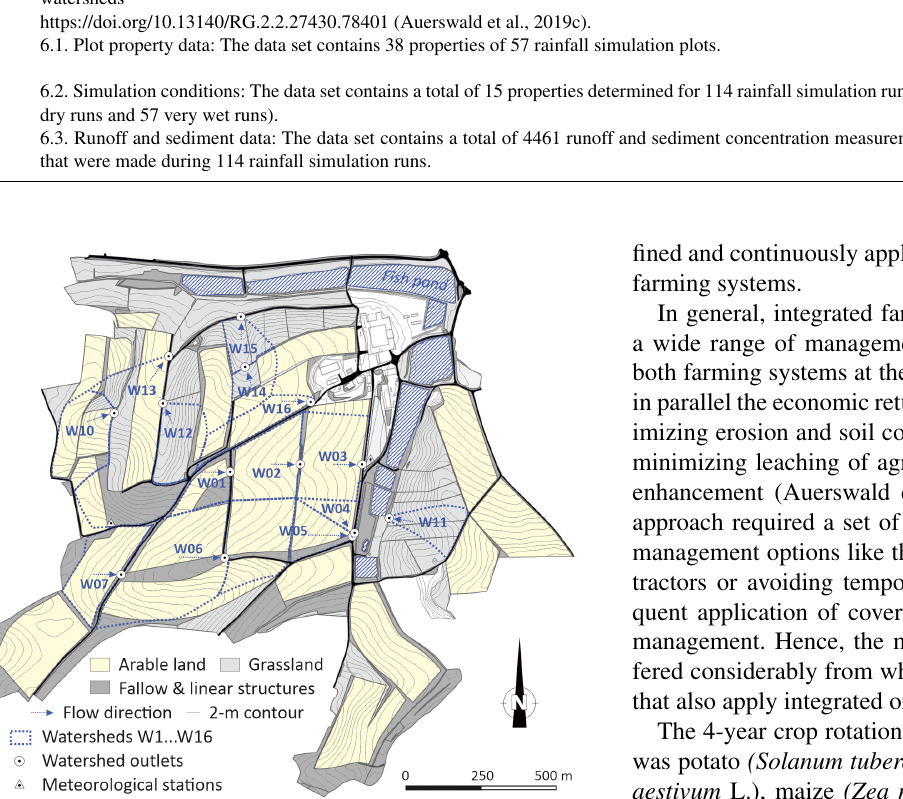
Figure 2. Land use and monitored watersheds at the research farm (without area for cropping experiments). Numbers ≤ 6 indicate in- tegrated management, numbers ≥ 7 indicate organic